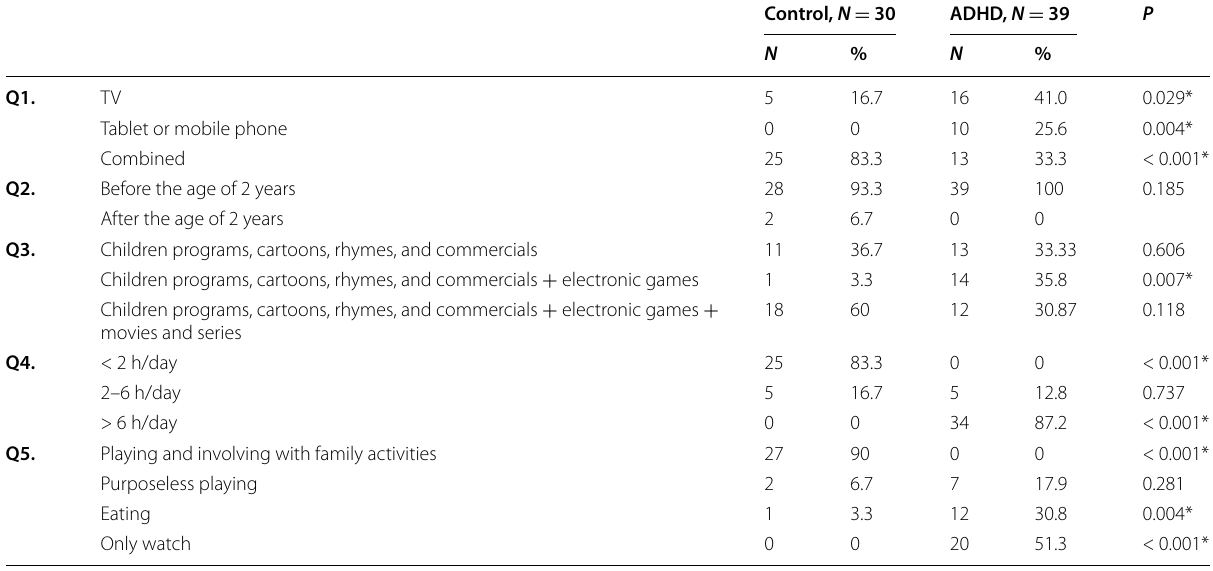
Table 3 Descriptive and comparative analysis between the studied groups regarding the answers of the constructed questionnaire